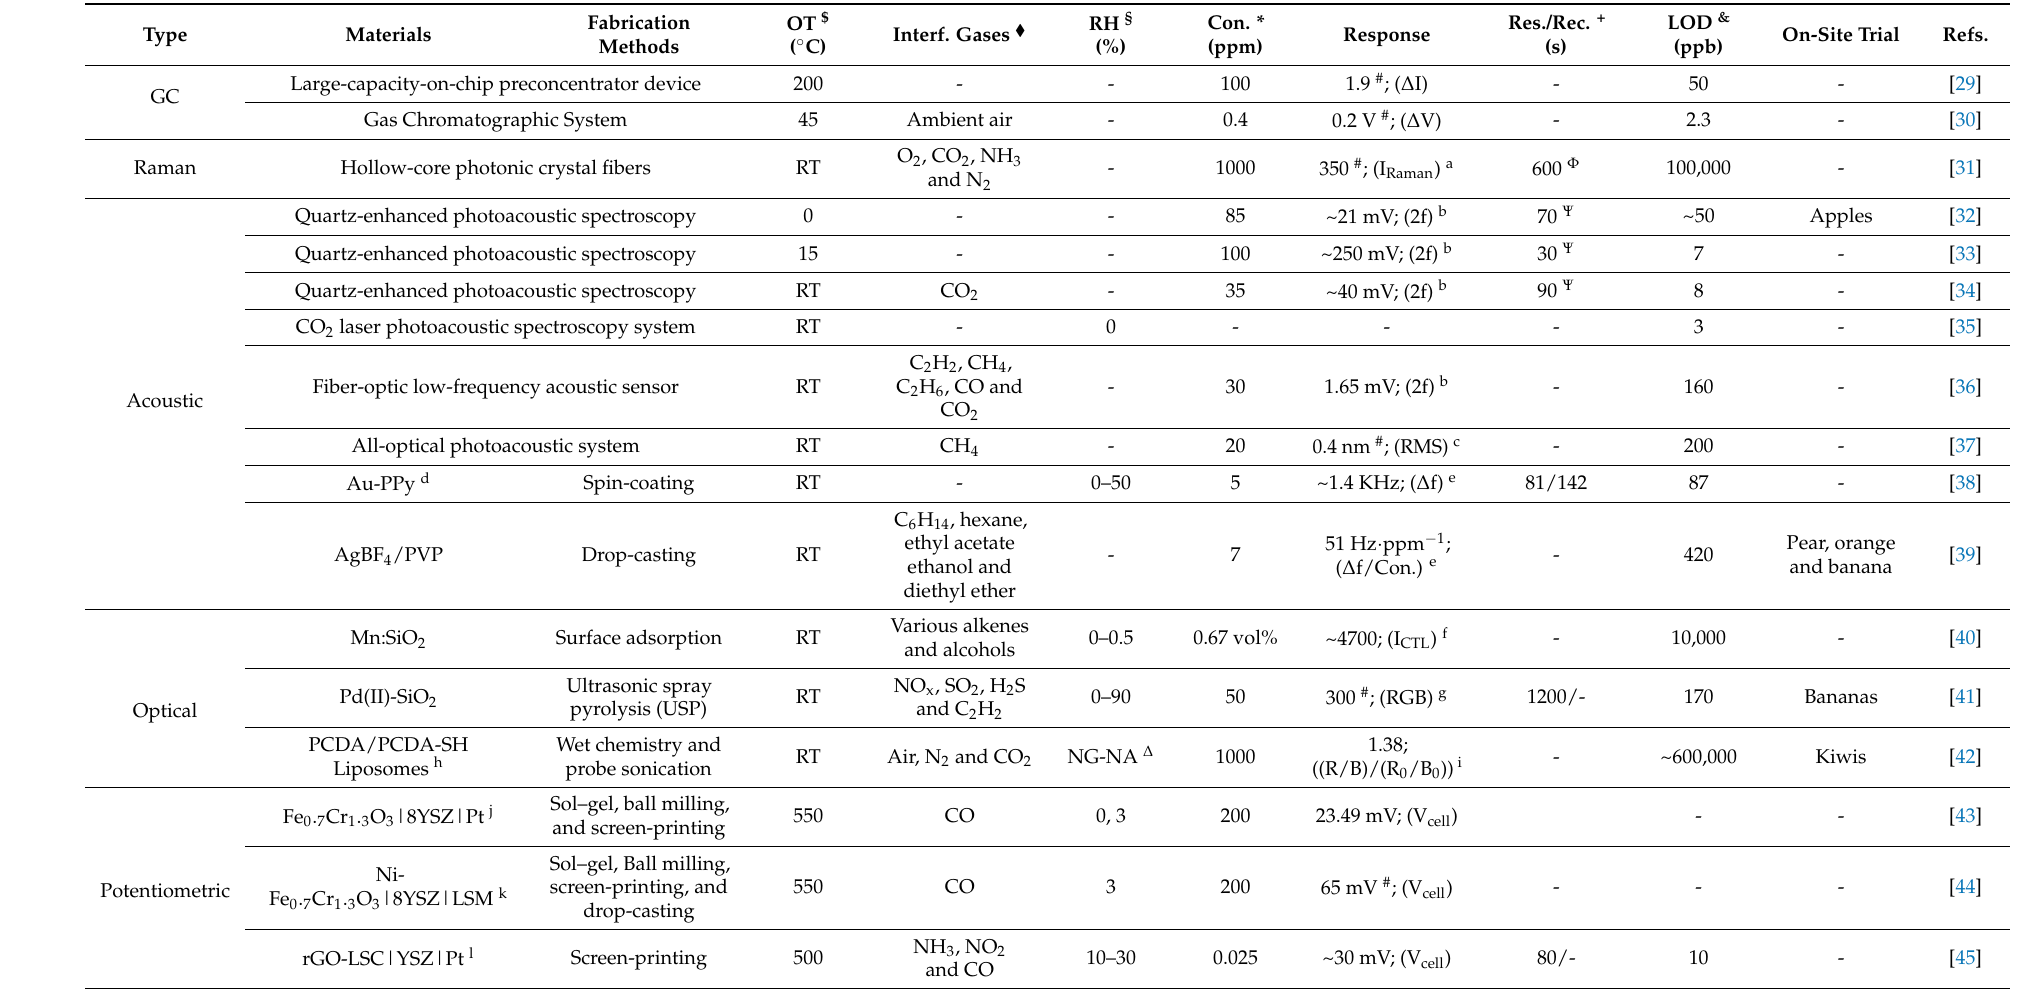
Table 1. The state-of-the-art ethylene gas-sensing